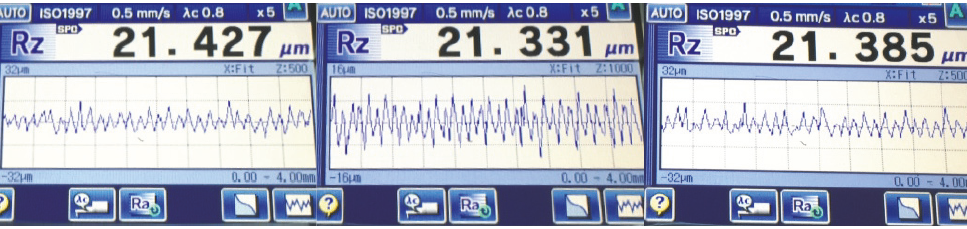
Figure 23: Pictures of Rz and profin graph of samples 1,2,3.